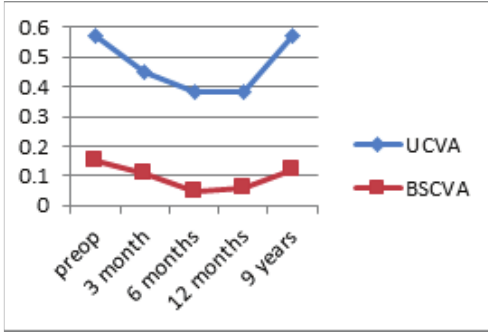
Figure 1. Stability of logMAR UCVA and logMAR BSCVA after corneal CXL.